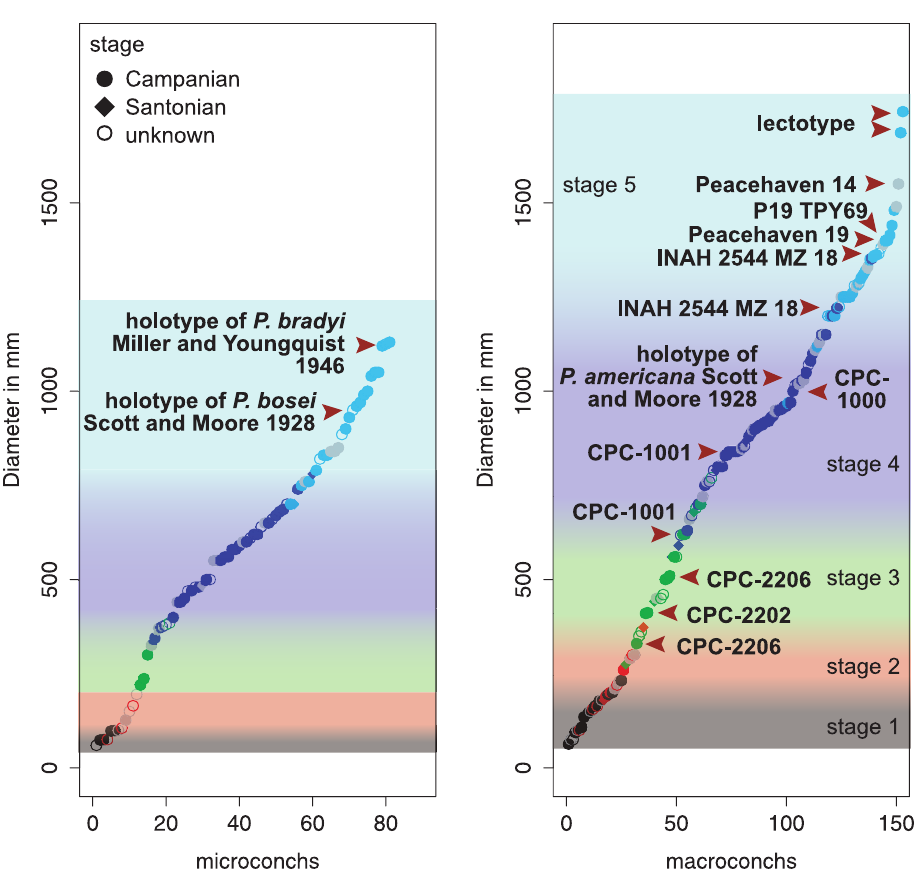
Fig 5. Shell diameter and associated growth stage in Parapuzosia ( P .) seppenradensis . The specimens from Mexico, Texas, Montana, England and Germany are separated after microconchs (left) and macroconchs (right). Colours refer to ontogenetic